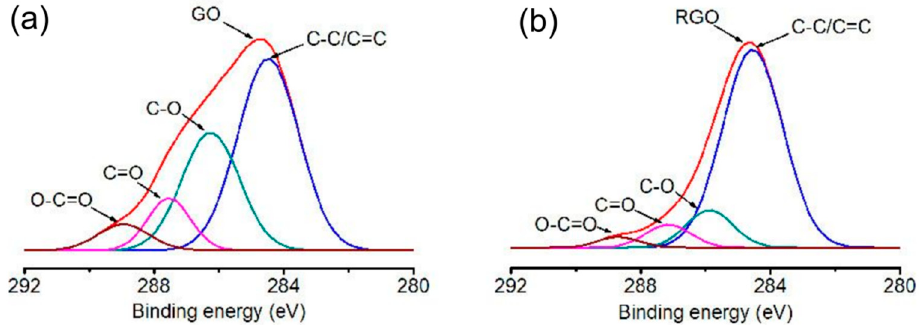
Figure 2. De-convolved X-ray photoelectron spectroscopy (XPS) spectra in the region of the C1s core electron binding energy. In graphene–oxide (GO) ( a ), three peaks associated with the bonding of oxygen to carbon are identified. In rGO ( b ), the overall intensity of these peaks is reduced relative to that originating from C-C bonds. Figure adapted from Chen et al. [23] with permission of Springer Nature. Stable dispersions of graphene oxide in appropriate solvents can be described as a colloid—a suspension of one phase (in this case a solid) inside